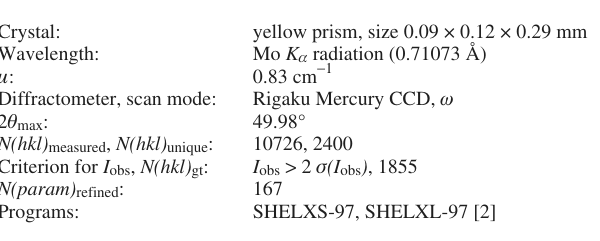
Table 1. Data collection and handling.